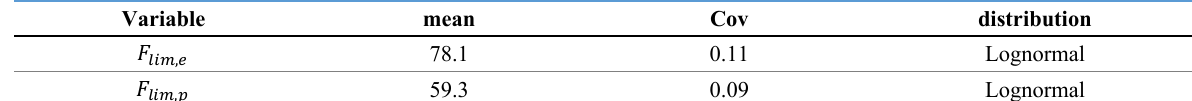
Table 6. Statistics for limit loads